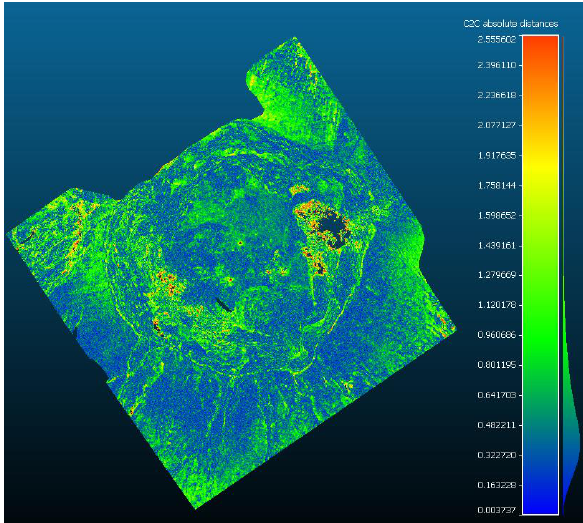
Figure 12. Point clouds comparison (distance) between Oct 19 and Oct